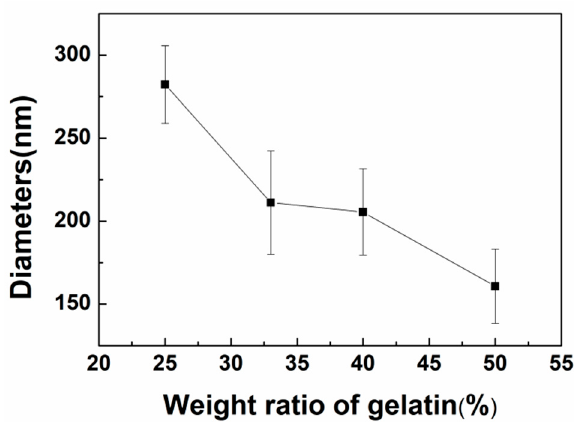
Figure 5. The relationship between the average diameters of gelatin/pullulan nanofibers and weight ratios of gelatin (total polymer concentration = 25% w / v ).